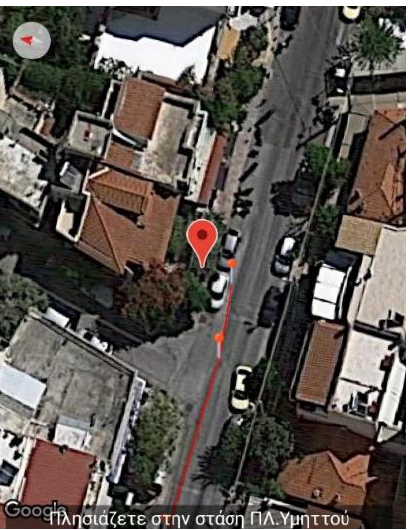
Figure 5. The application issues the instruction “Approaching Ymittos bus stop”.